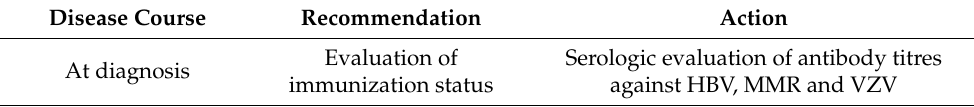
Table 1. Vaccine recommendations for children with inflammatory bowel disease